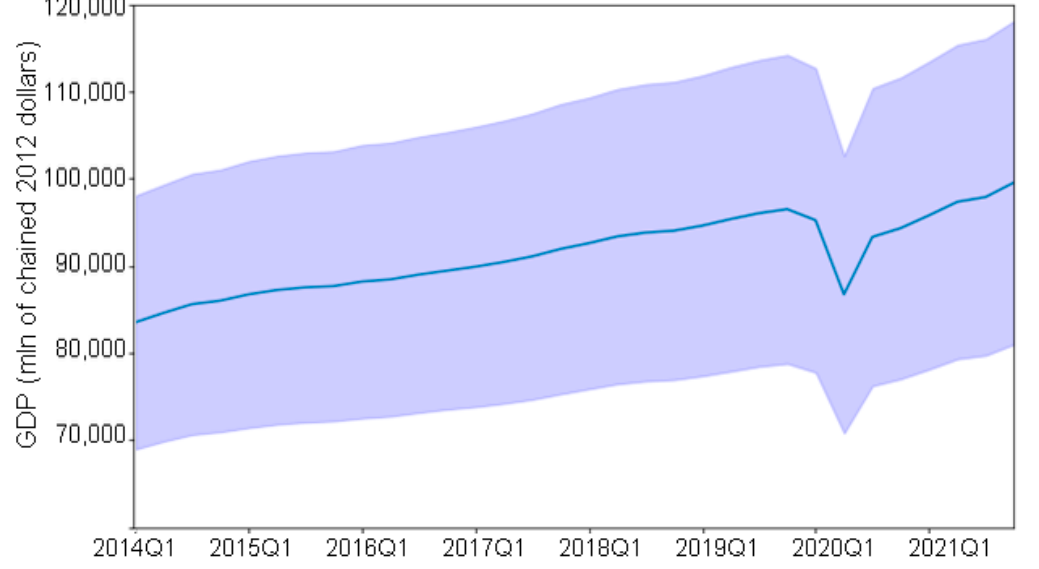
Figure 3. The average state quarterly GDP for the 48 states and DC for 2014–2021. The shaded area shows ±1 standard error from the mean.